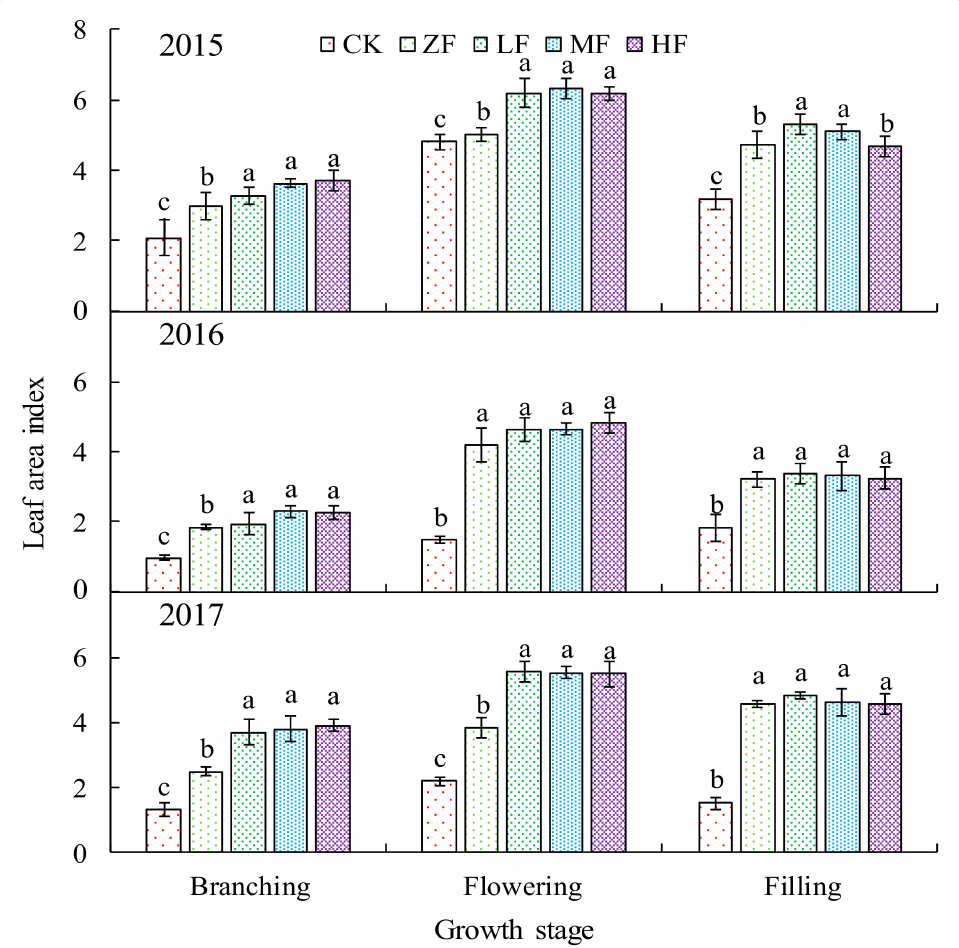
Figure 7. Leaf area index at branching, flowering, and filling stages of tartary buckwheat in 2015–2017. HF: plastic mulching and high fertilization; MF: plastic mulching and moderate fertilization; LF: plas- tic mulching and low fertilization; ZF: plastic mulching and zero fertilization; CK: traditional non- mulching and zero fertilization. In each growing season, mean values (n = 3) followed by different letters within a column are significantly different among treatments at p < 0.05. Bars are error bars of the means (n =